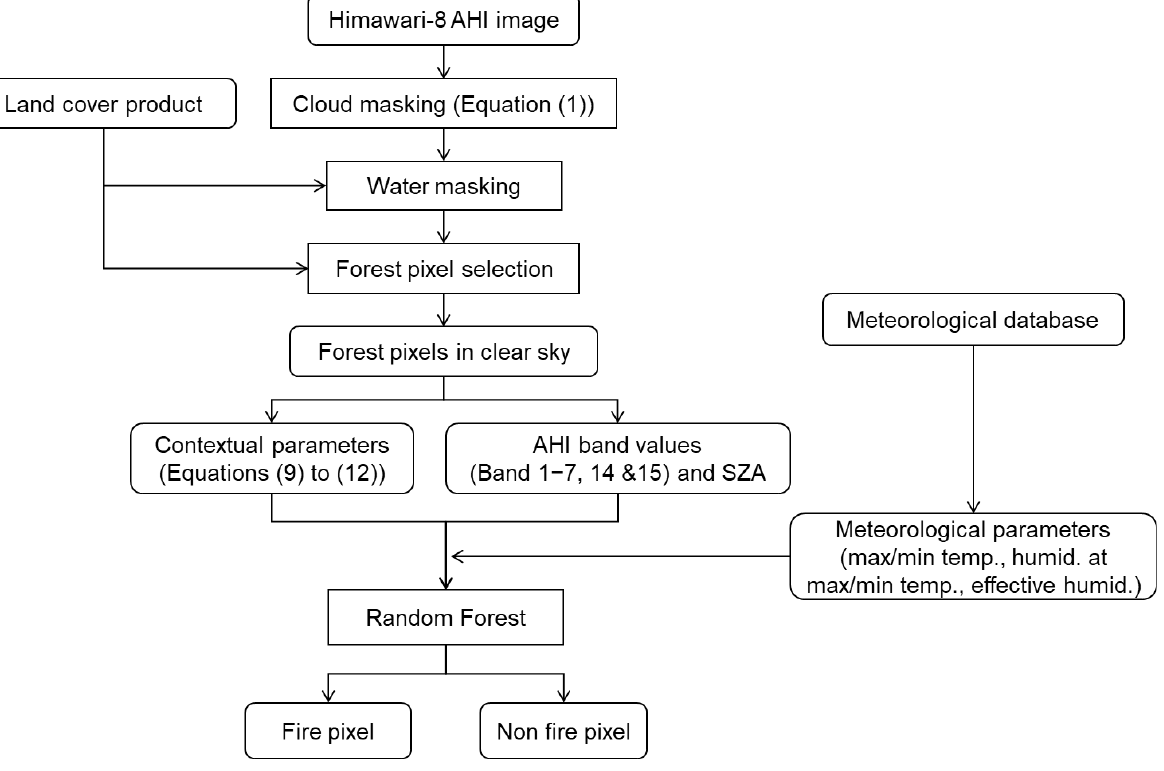
Figure 1. Processing flow of proposed method.